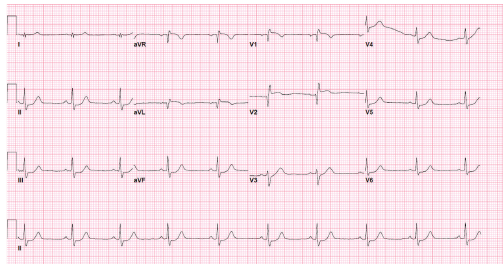
Figure 1: EKG showing ST segment elevation in leads V1, V2, and aVL and ST segment depressions in leads II, III, aVF, V5, and V6.